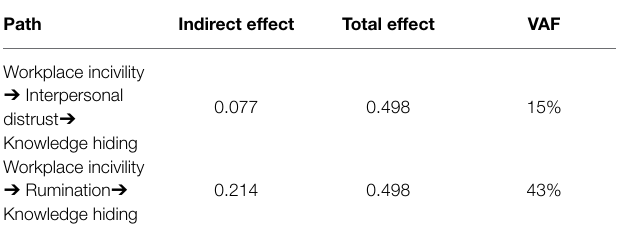
TABLE 5 | Mediation